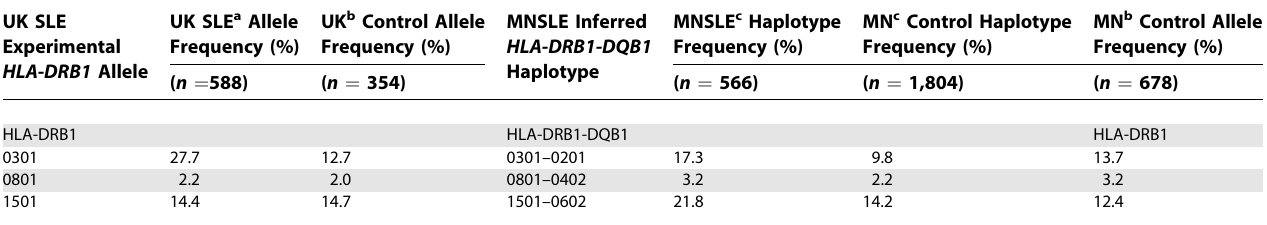
Table 4. Comparison of HLA-DRB1 Allele/Haplotype Frequencies in UK SLE and US (Minnesota) SLE Cohorts UK SLE a UK SLE Experimental HLA-DRB1 Allele